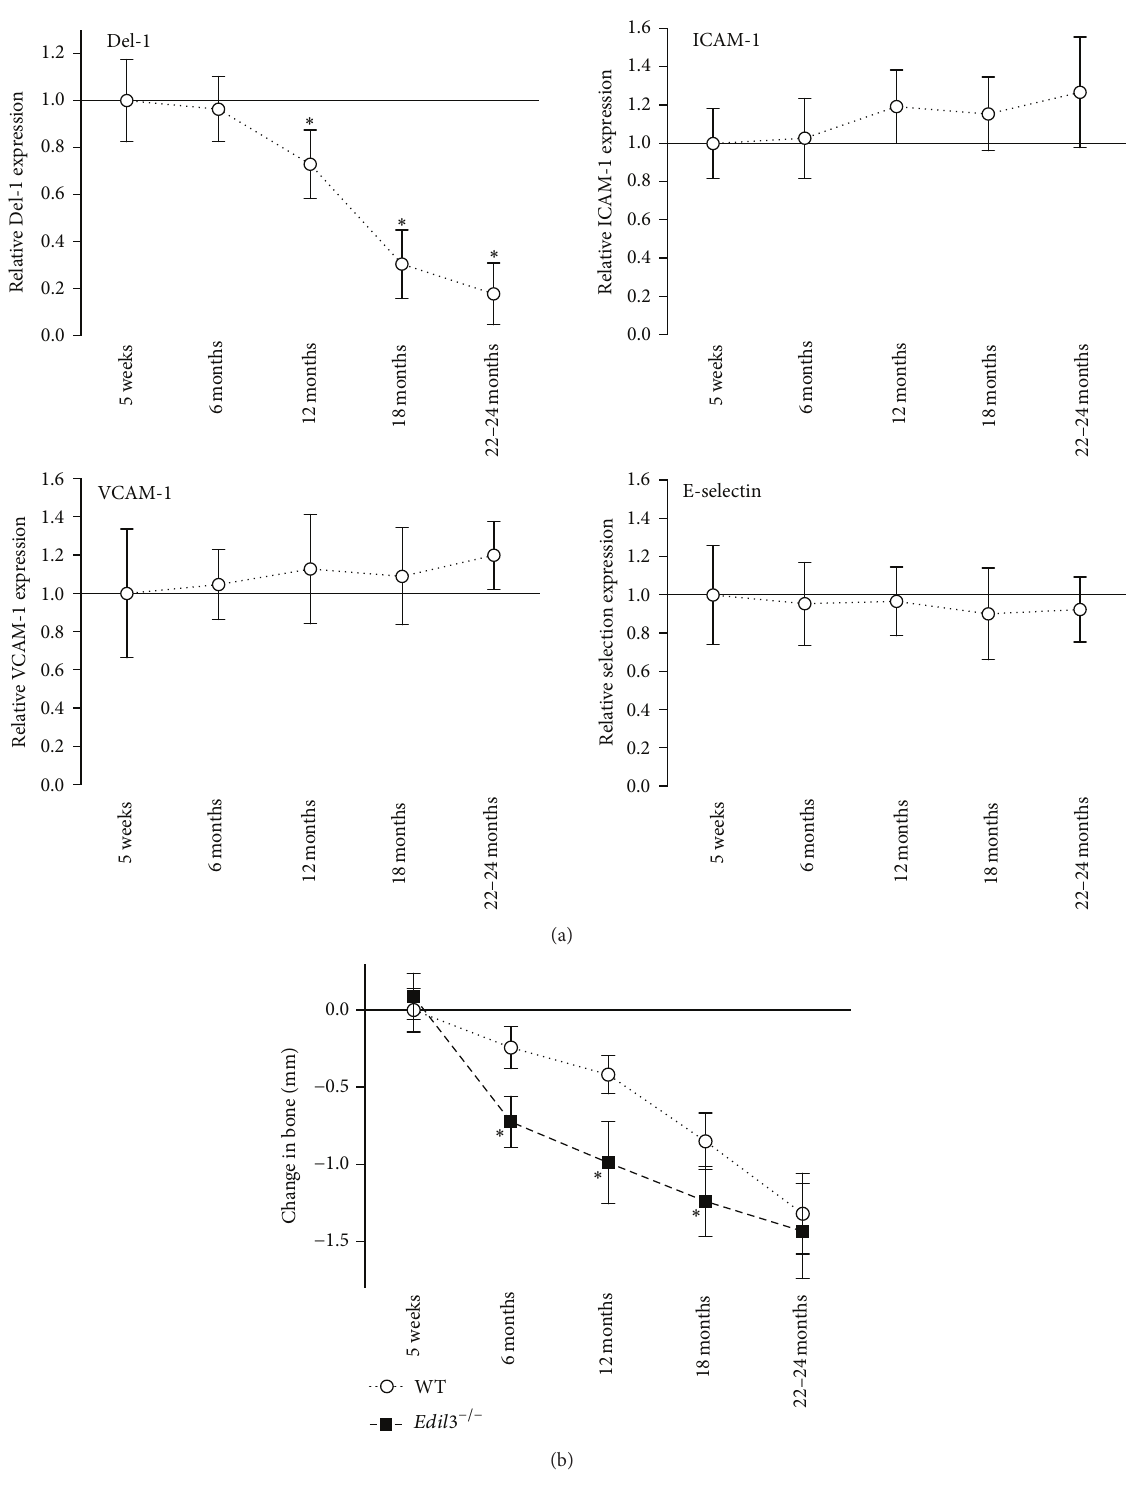
Figure 3: Expression of Del-1 and endothelial cell adhesion molecules and bone loss as a function of age. (a) Gingiva dissected from WT mice at the indicated ages were processed for quantitative real-time PCR analysis of mRNA expression of the indicated genes; results were normalized to those of GAPDH mRNA and expressed as fold change in transcript levels relative to those of 5-week-old WT mice, the average value of which was taken as 1. (b) Time course of naturally occurring bone loss in aging WT mice in comparison to age-matched 𝐸𝑑𝑖𝑙3 −/− mice; negative values indicate bone loss relative to bone measurements in 5-week-old wild-type mice. Data are means ± SD ( 𝑛 = 6 – 8 mice per group). ∗ 𝑃 < 0.01 as compared to 5-week-old WT mice (a) or between 𝐸𝑑𝑖𝑙3 −/− and WT mice